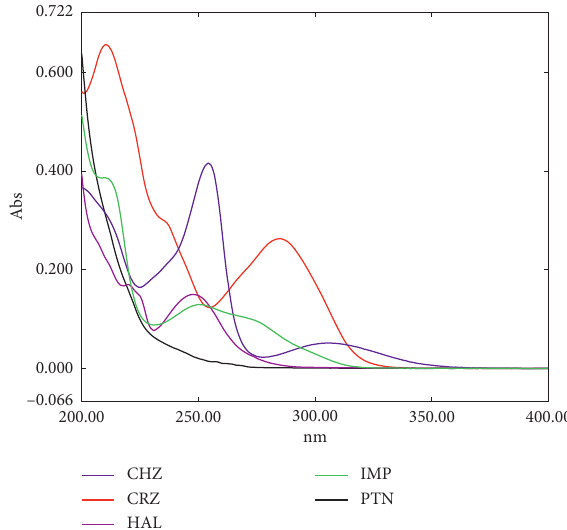
Figure 1: UV absorption spectra of 5 μ g/mL of chlorpromazine (CHZ), carbamazepine (CRZ), haloperidol (HAL), imipramine (IMP), and phenytoin